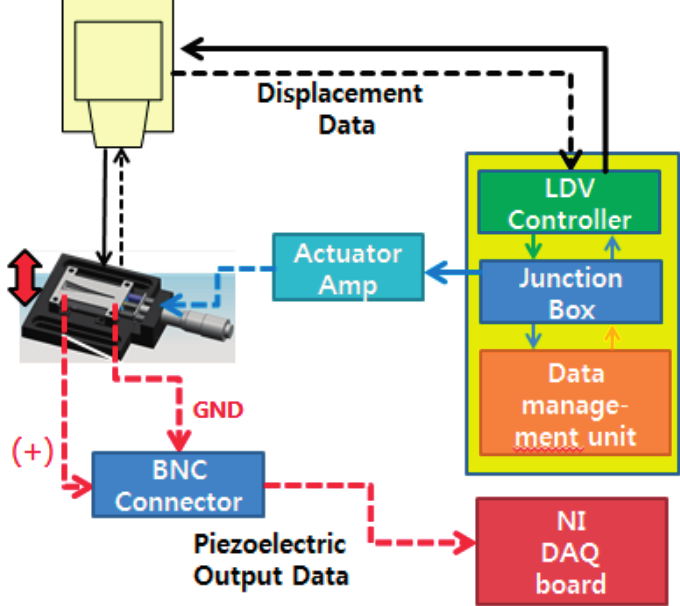
Figure 8. Schematic of experimental setup for characterization of the developed PAC: solid lines are connections for control and actuation signal and dotted lines are connections for measuring vibration and piezoelectric